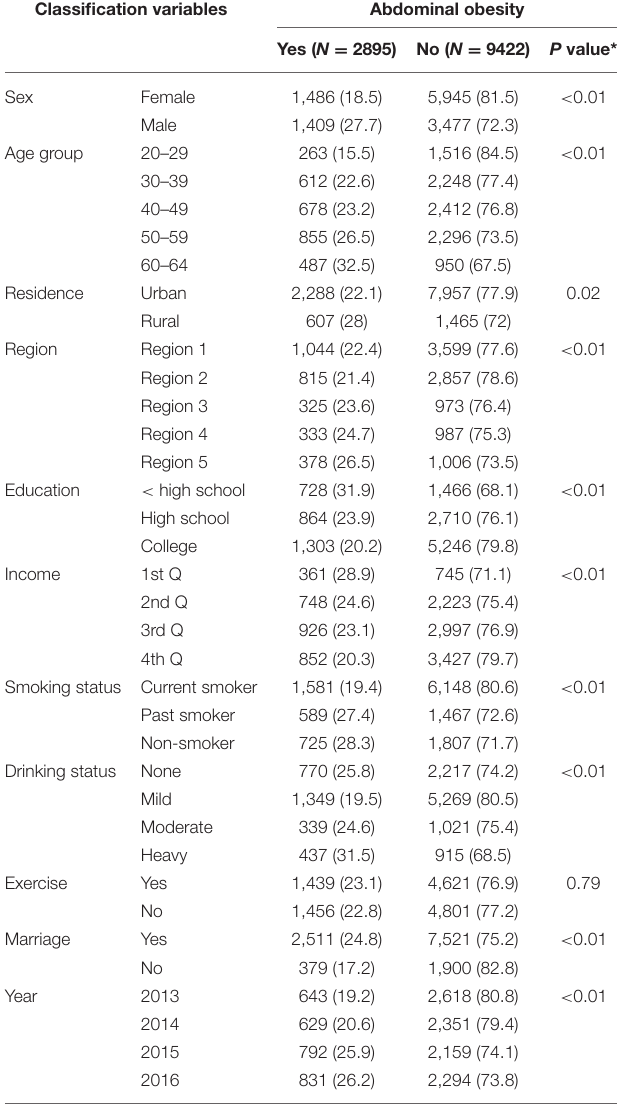
Values represented number of the participants and percentages. * Chi square test for each classification variables for metabolic syndrome. The cutoff values for abdominal obesity were ≥ 90cm in men and ≥ 85cm waist circumferences in women. CI, confidence intervals. Region 1, Seoul, Incheon, Kyunggi area and Gangwon-area; Region 2, Chunngchung area, Daejeon, and Sejong; Region 3, Kyungbook, and Daegu; Region 4, Busan